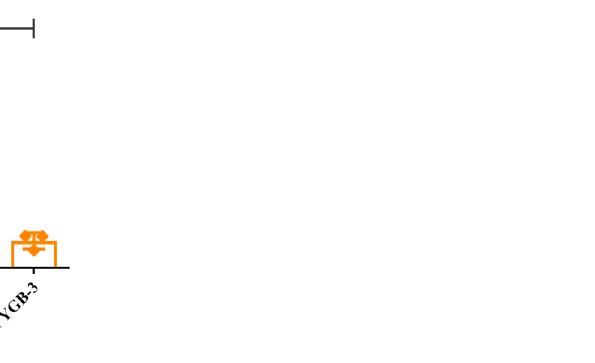
Figure 2. RTPCR for screening adeno-associated viruses. Data represent mean ± SD (*** p < 0.001).